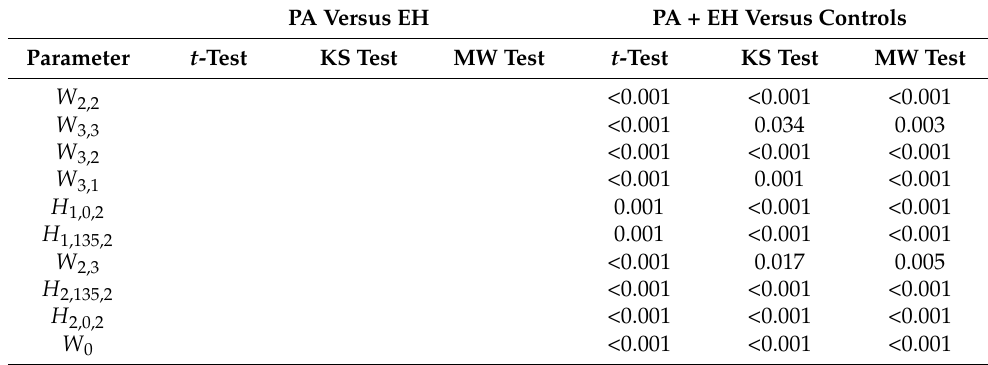
Table 5. Differences between the PA + EH and control groups in the first 10 texture descriptors. PA Versus